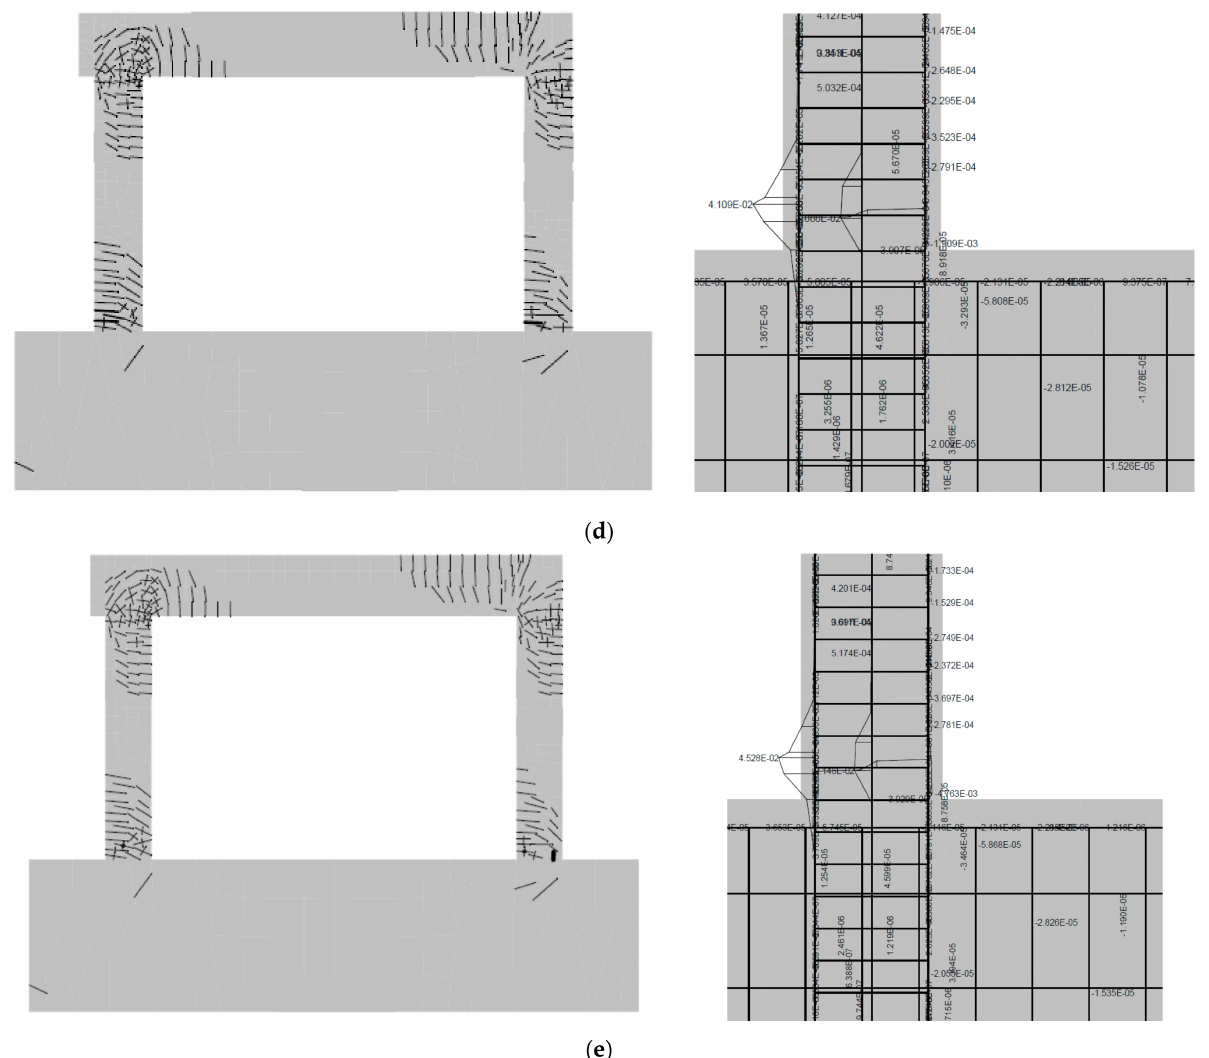
Figure 7. The progressive damages in term of concrete cracking and crushing as well as yielding and buckling of the reinforcing bars. ( a ) At a load of 20 kN, fine cracks appear at locations with high intensity of tensile stresses. The corresponding maximum tensile strain of the reinforcing bars (at the bottom column) at this load level is 6.343 × 10 − 4 , which is still below the yield strain (1.95 × 10 − 3 ). ( b ) At a load of 35 kN, more formation of fine cracks appeared and first yielding of the reinforcing bars at the bottom of columns is observed. The maximum reinforcement strain at this location reaches 2.107 × 10 − 3 which is above the yield strain. ( c ) At a peak load, more cracks and a greater number of yielded reinforcing bars (including at the upper column) are observed. ( d ) At a post-peak, significant cracks in the compression zones may lead to crushing of concrete especially at the bottom columns and in turn, higher stresses are transferred to the compression reinforcing